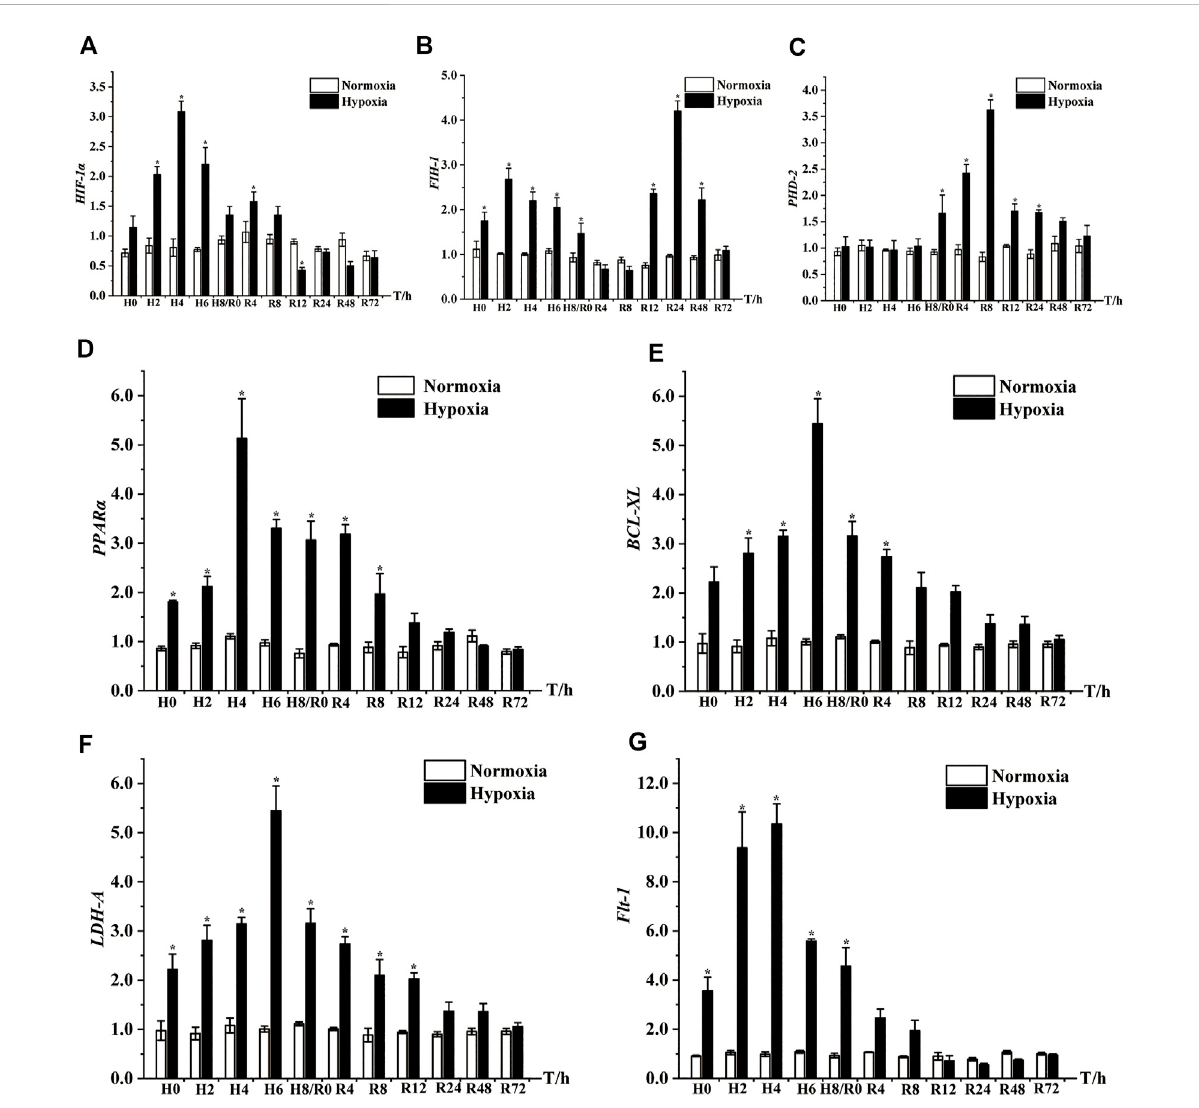
FIGURE 7 Expression patterns of seven key DEGs in muscle of E. coioides after hypoxic stress and reoxygenation, including HIF-1 α (A) , FIH-1 (B) , PHD-2 (C) , PPAR α (D) , BCL-XL (E) , LDH-A (F) , Flt-1 (G) . H: Hypoxia; R: Reoxygenation. The results were represented by mean and standard error, and the difference of labeled lowercase letters indicated signi fi cant difference ( p < 0.05